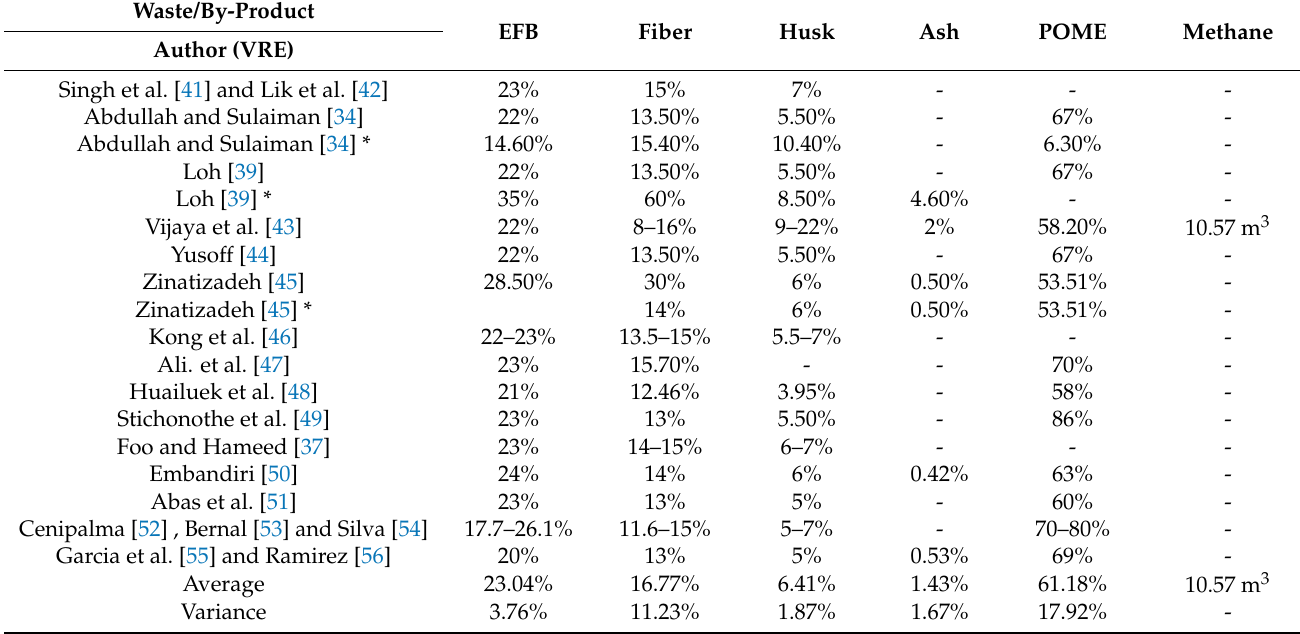
Table 4. Quantification of the Reference Values (VRE) of waste and by-products derived from processing one ton of RFF.